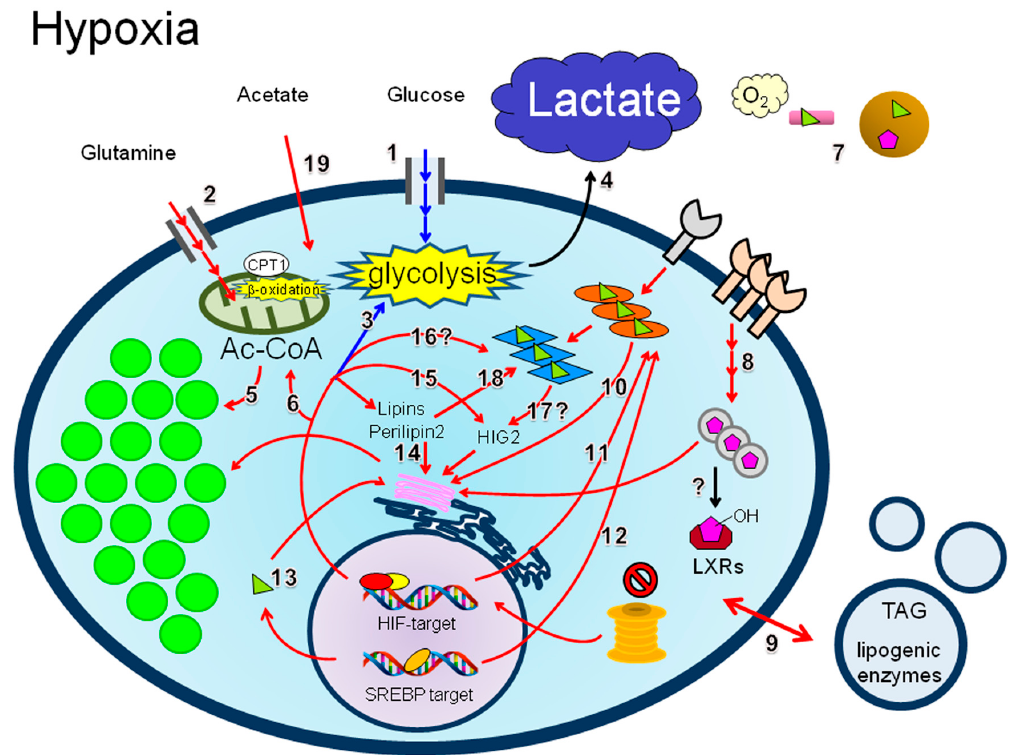
Figure 2. Schematic of the possible metabolic routes associated with LD synthesis in cancer cells exposed to O 2 -deficient conditions. Under hypoxia, cancer cells are expected to have restricted access to serum components. Cancer cells are also expected to secrete high levels of lactate under hypoxia. Serum components and lactate are designated with small and large font sizes, respectively. Under hypoxia, glycolysis and β -oxidation should be accelerated and suppressed, respectively. Accordingly, facilitated glycolysis and inactivated fatty acid oxidation are represented by large and small font sizes, respectively. Metabolic routes (1–19) possibly associated with LD synthesis and glycolysis are designated with red and blue arrows, respectively. Other routes are shown in black arrows. The abbreviations used are as follows: CPT1 = carnitine palmitoyltransferase 1; HIG2 = hypoxia inducible protein 2; TAG = triacylglycerol. The symbol “?” is indicative of potential contribution in cancer cells.